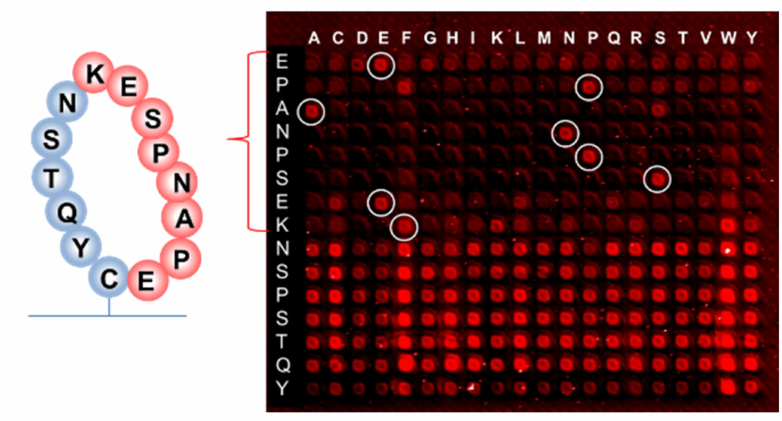
Figure 11. ( right ) Fluorescence scan of the substitutional array for the cyclized peptide EPANPSEKN- SPSTQY after incubation with rituximab and subsequent immunostaining. The white circles show amino acids from the original sequence EPANPSEK. The cyclic peptides were formed via the thioether macrocyclization. ( left ) The RTX target sequence and the scheme of the peptide cycle. Although hydrophobic amino acids W and F are not present in the RTX target sequence, selective binding remains when the proline P at the second position of the EPANPSEK epitope is replaced by phenylalanine F, and lysine K at the end of EPANPSEK is replaced by tryptophan W. Other substitutions at these positions resulted in the disruption of the selective binding with